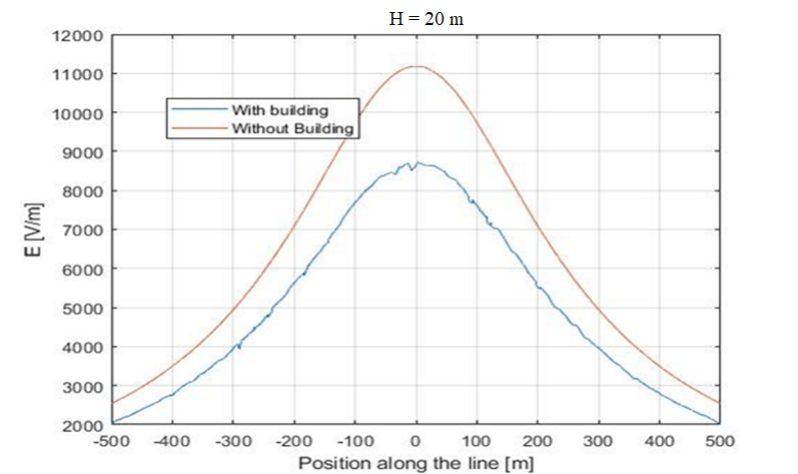
Figure 8. Comparison between the electric field measured along the whole line. (C) d = 10 m, and H varies from 5 to 50 m.